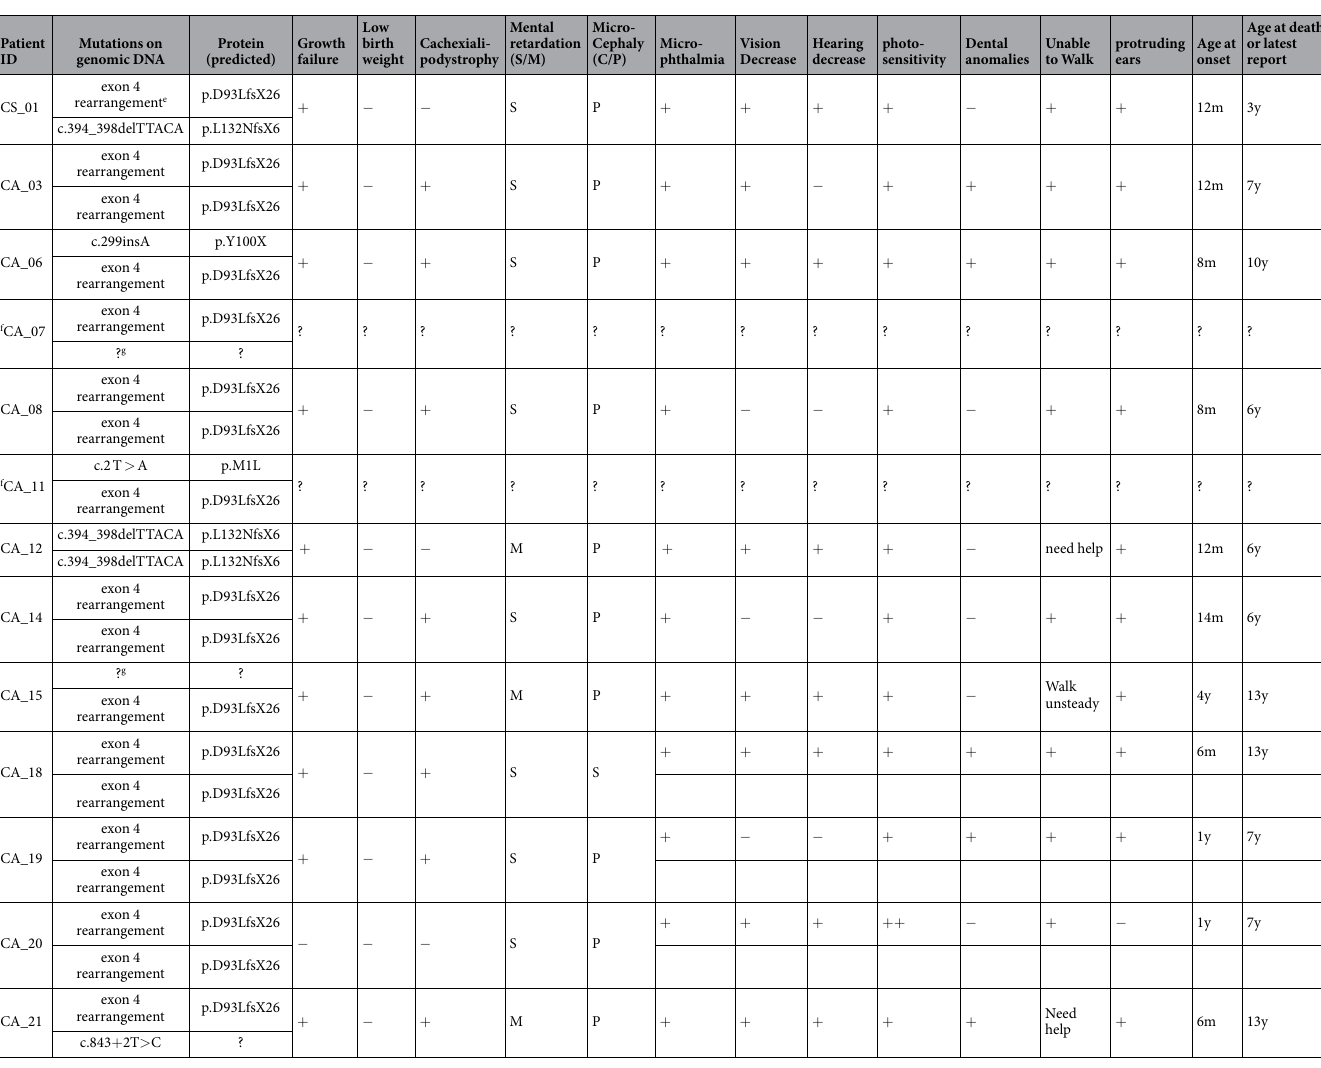
Table 1. Phenotypes and genotypes of all CS-A patients. a Moderate (M) or severe (S). b Congenital (C) or postnatal (P). c Yes ( + ), no ( − ). d Age at death. m, months; y, years. e Exon 4 rearrangement =